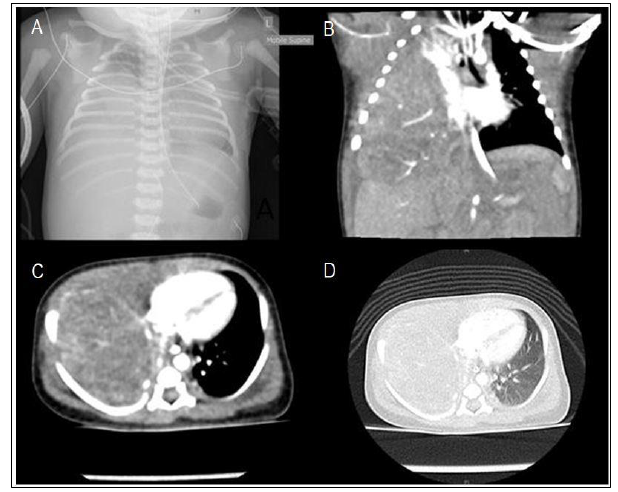
Figure 1: (A) Chest X-ray of Case 1 on Day 1 of life showing a homogenous opacity in the right hemithorax associated with mediastinal shift to the left. (B) Coronal view of CT chest with a contrast of Case 1 on Day 2 of life showing solid appearing le- sions in right hemithorax without air-filled components. (C) Axial view with abdominal window (D) Axial view with lung window Case 2: A female twin was born at 35+5 weeks gesta- tion via elective cesarean section. Apgars at birth were 7 and 9. She had normal antenatal scans. After birth, she developed respiratory distress and was trans- ferred to our institution. She was initially managed with CPAP but required intubation on day 2 of life. Chest x-ray (Fig. 2) showed a homogenous opacifica- tion of the right middle and upper zones. CT chest sion in the right upper hemithorax which was not tumor.